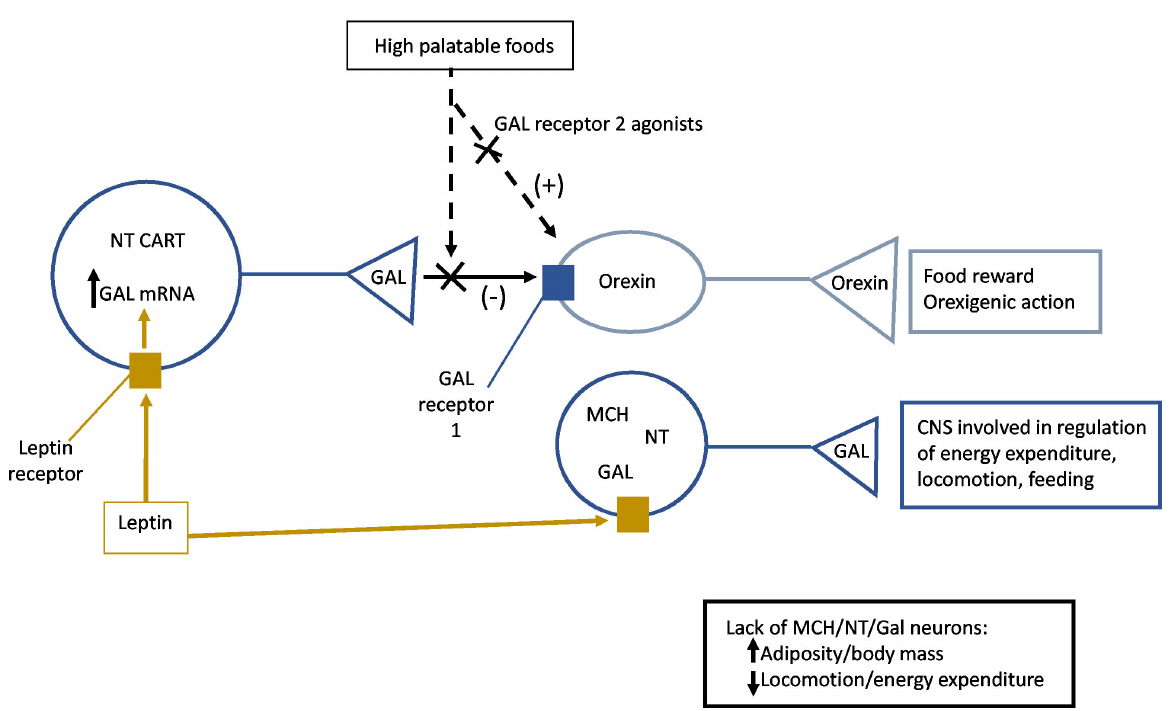
Figure 4. Extended perifornical area: neural pathway and neuroactive substances involved. Leptin inhibits the activity of neurons containing orexin. This inhibition is mediated by GAL after binding to the GAL receptor 1 expressed in neurons with orexin; however, high palatable foods block the inhibitory action of leptin on orexin neurons and stimulate the activity of the latter neurons. ↑ : increase; +: activation (orexigenic action); -: inhibition (anorexigenic action). GAL: galanin; GAL receptor 2 agonists restore the ability of leptin to restrain palatable food eating. CART: cocaine- and amphetamine-regulated transcript peptide; MCH: melanin-concentrating hormone; NT: